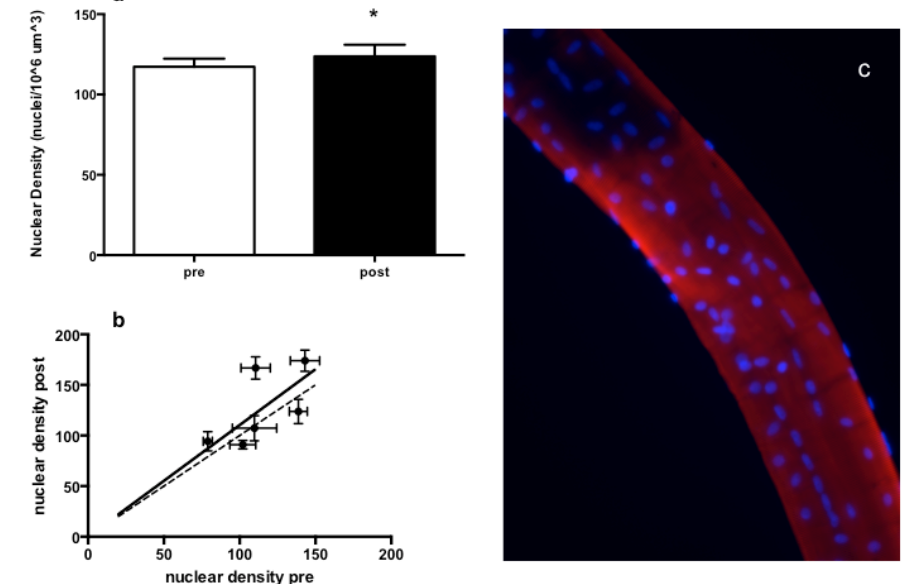
Figure 7. Increase in nuclear density after eight weeks of RT. * p < 0.05. ( a ) Average values pre ‐ and post ‐ training from six subjects each with eight fibers analyzed in each condition; ( b ) correlation between the average myonuclei density post ‐ (ordinate) and average density pre ‐ (abscissa) training calculated for each subject. Two subjects showed no change or a slight decrease, while four subjects showed an increase. The regression line is Y = 1.10 ± 0.08X, not significantly different from the perfect line with slope 1; ( c ) Single muscle fibers stained with anti ‐ actinin antibody (red) and with Hoechst nuclear staining (blue).